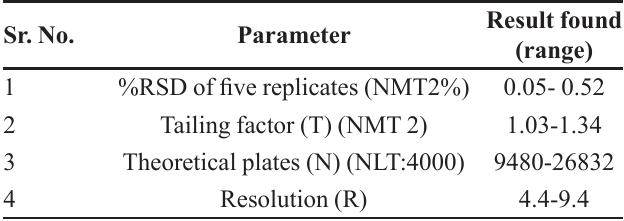
TABLE 1 - System suitability Sr. No.